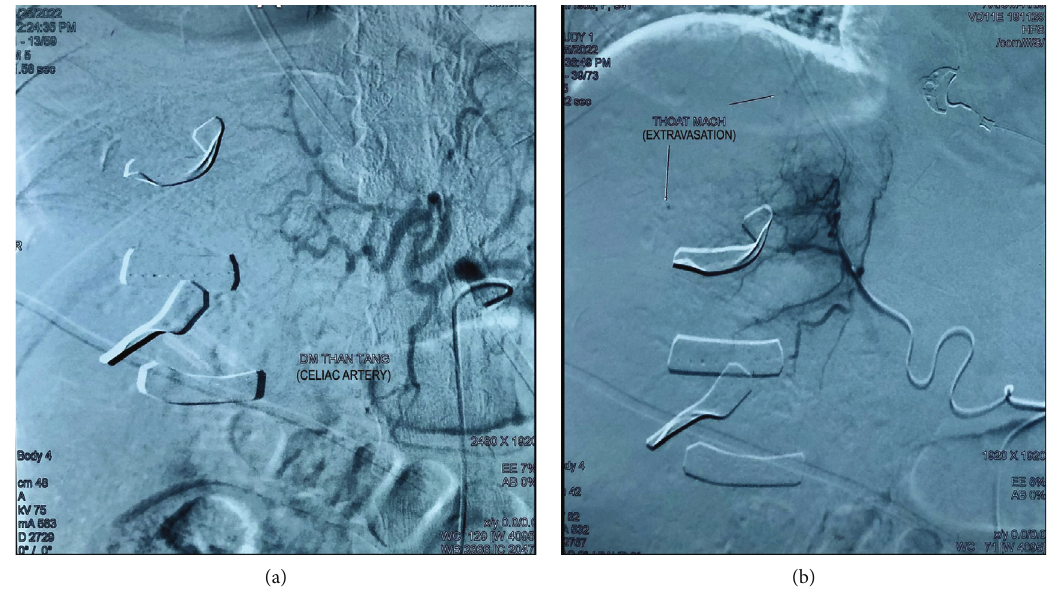
Figure 1: Extravasation signs on DSA. (a) TAE was performed via the celiac artery and (b) spot signs showing extravasation contrast. DSA: digital subtraction angiography; TAE: transcatheter arterial embolization. In the ICU, the patient was managed with mechanical ventilation, broad-spectrum antibiotics, fl uid and blood transfusions, vasopressors, tranexamic acid, and magnesium sulfate for eclampsia prophylaxis.